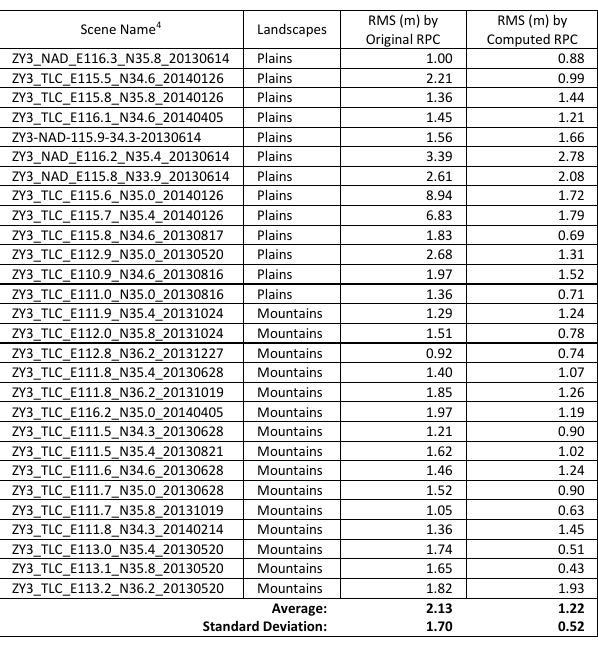
Table 3 ZY-3 testing scenes and accuracy results